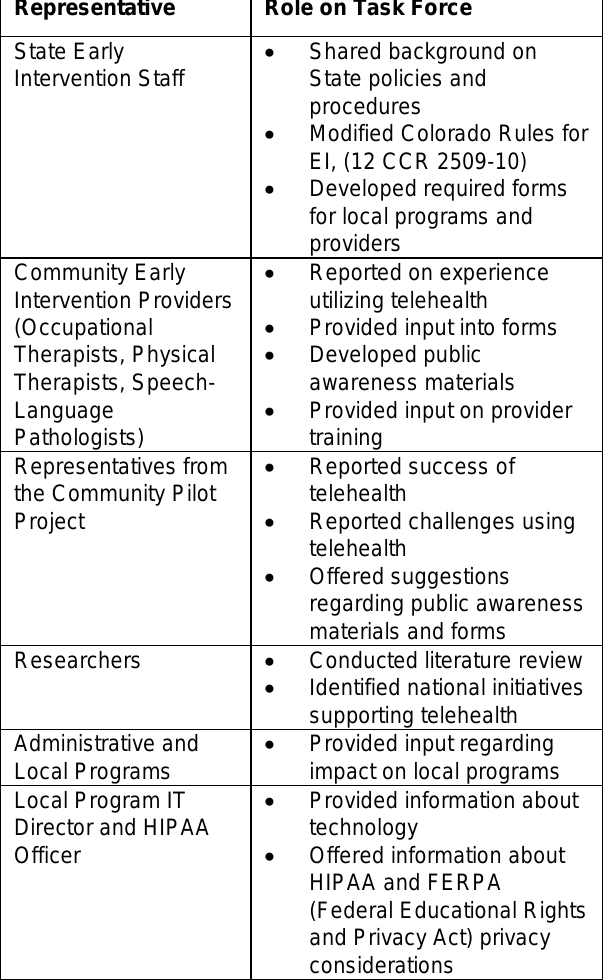
Table 1. Stakeholders and Role on Task Force